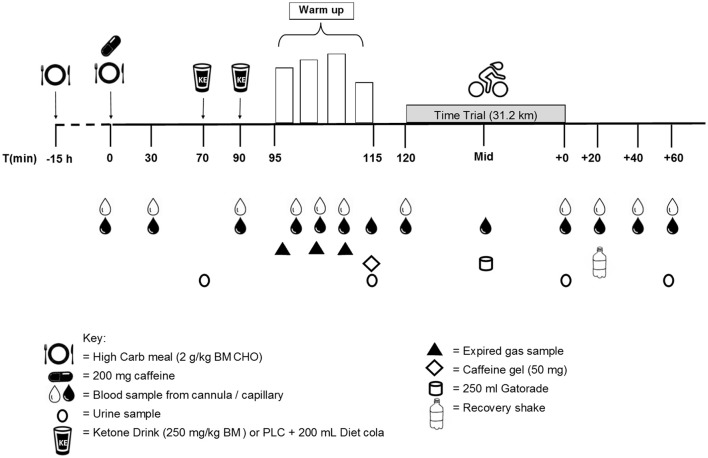
Overview of study design.